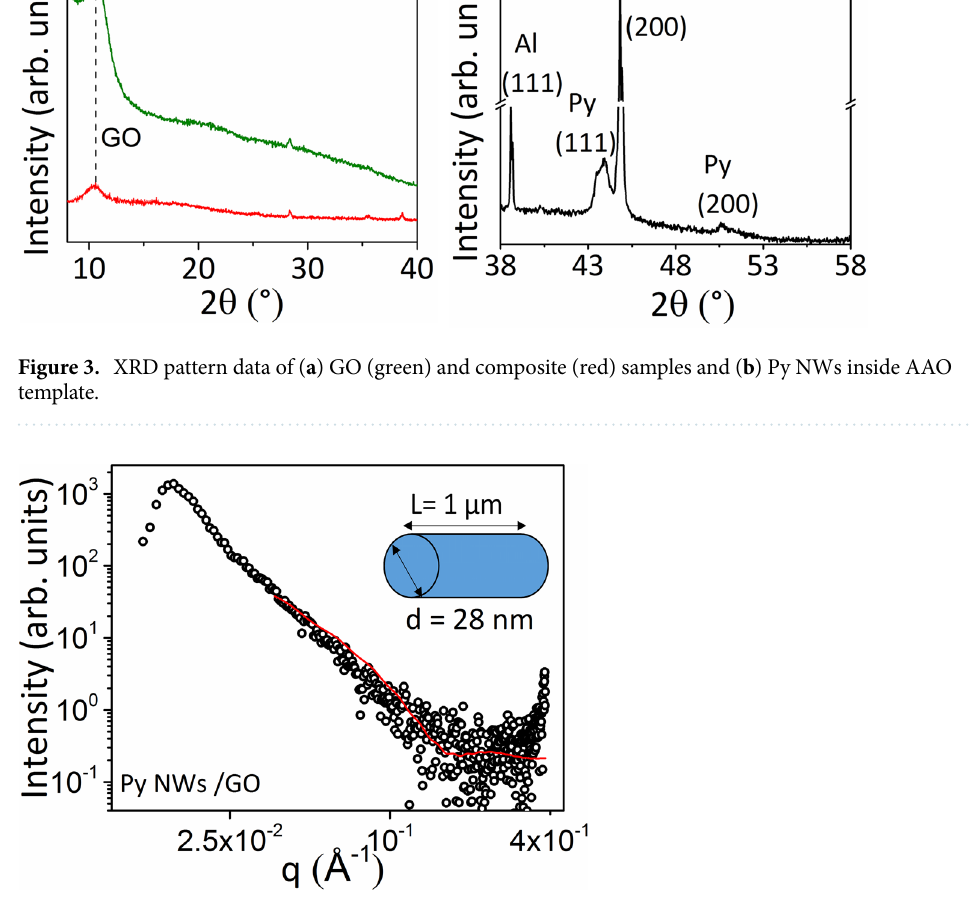
Figure 4. Experimental (black circles) and fitted (red line) SAXS data of composite assuming a cylindrical